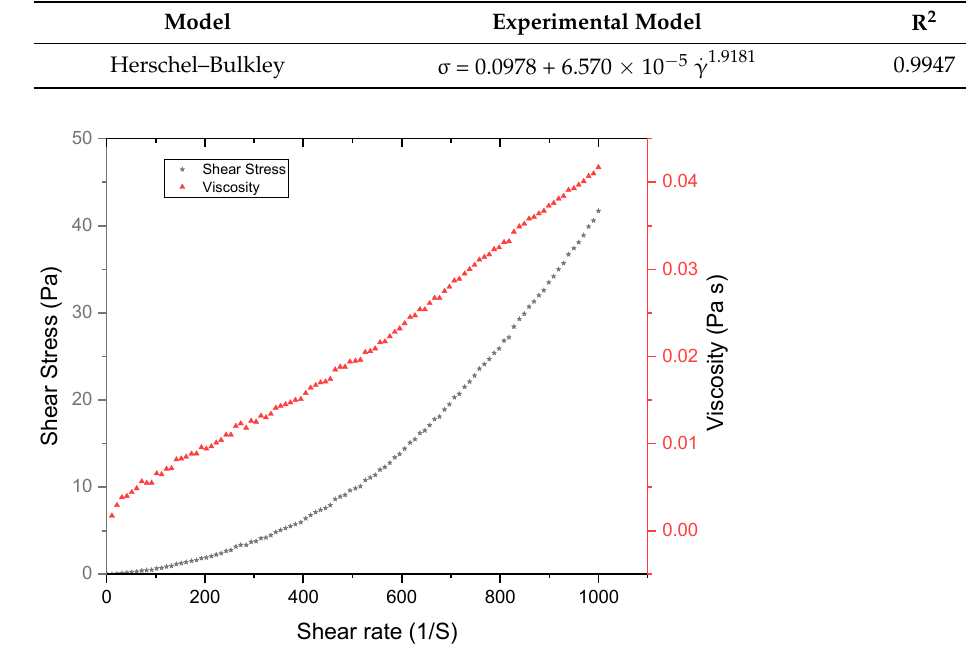
Figure 2. Rheological behavior of free dextranase at 25 °C. Commercial dextranase comes from the fungal strain Chaetomium Spp. The calculated protein concentration was 0.9620 mg/mL, the enzymatic activity was 0.55 U/mL, and the higher enzymatic specific activity was 0.75 U/mg enzyme at 55 ◦ C and 5.5 pH. Similar pH conditions were obtained by [31], the authors of which purified and isolated 12 strains of enzymes and obtained a maximum activity of 120 U/mL against 0.55 U/mL shown in Figure 3; we could say that this difference could be because of the origin of the enzyme and also the different methodology to calculate enzyme activity. Further, we could see differences in these parameters according to the immobilization method and dextranase strain used